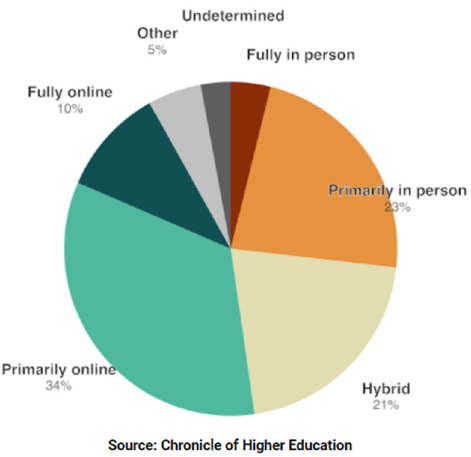
Figure 1. Variation in Fall 2020 Reopening Plans of U.S. College and Universities.